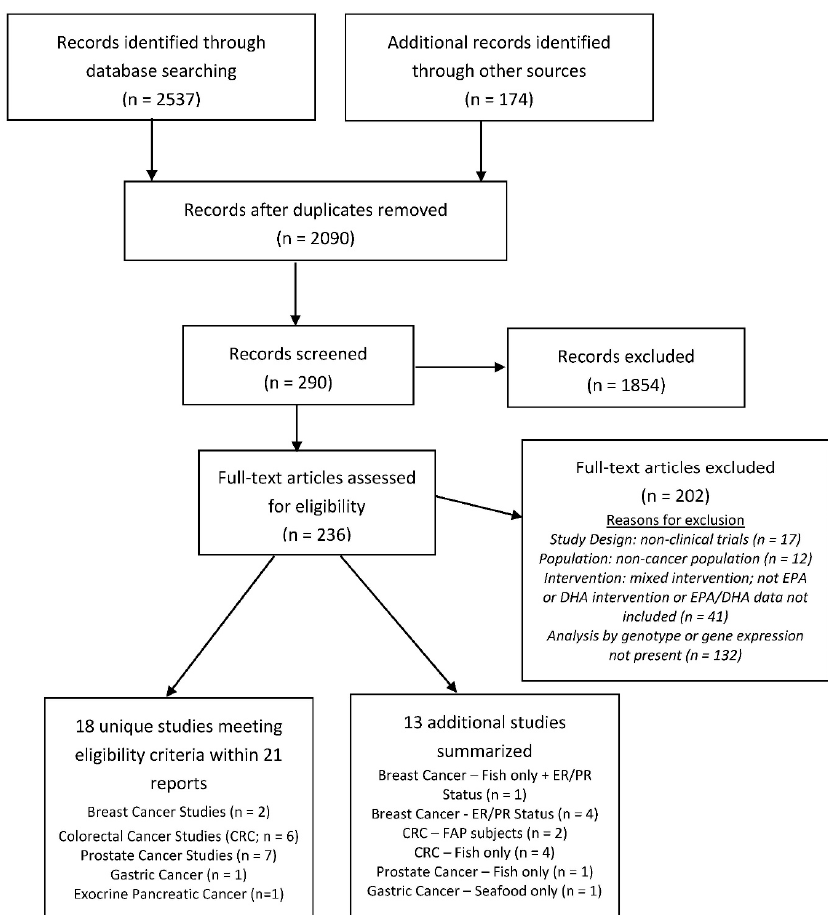
Figure 2. Flow diagram of the search and screen process used in study selection.